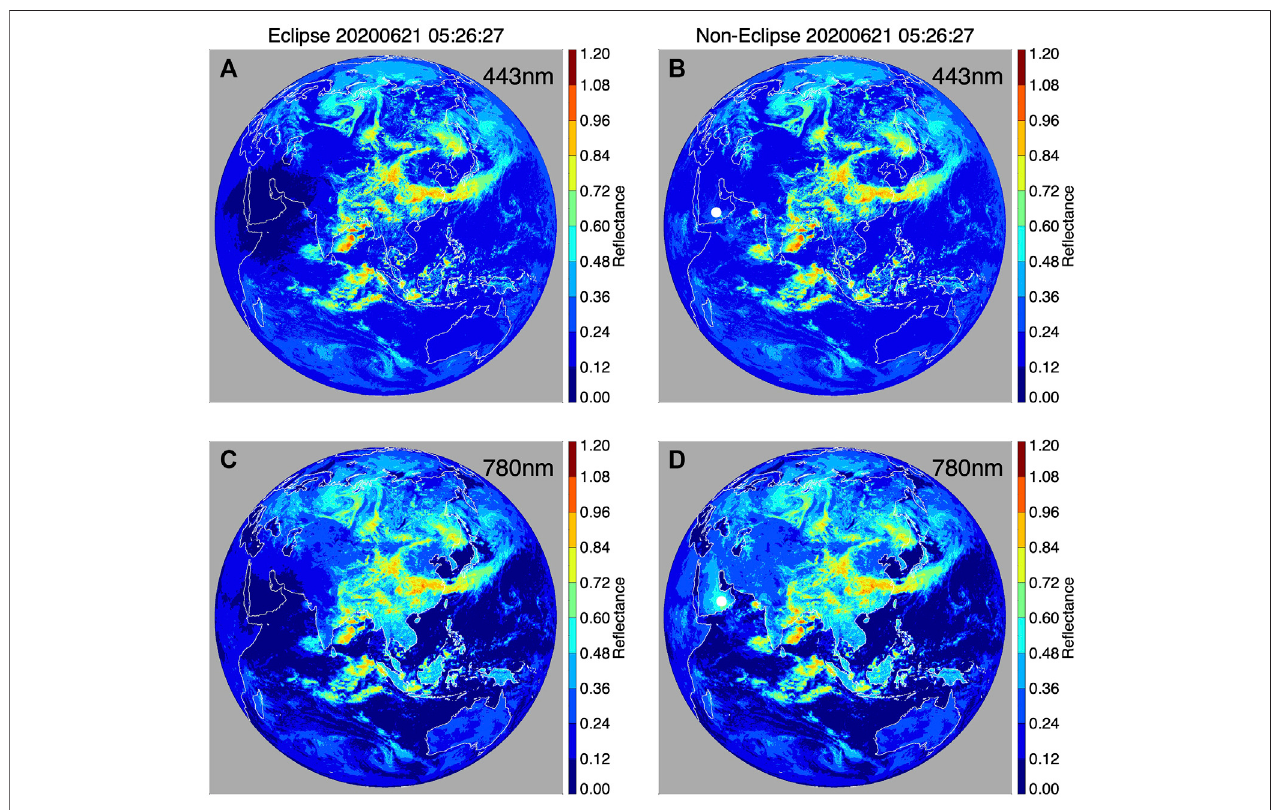
FIGURE 4 | (A) EPIC image at 443 nm acquired during the 21 June 2020 eclipse when the center of the Moon ’ s shadow was in Arabian Peninsula; (B) the recoveredimageforhypotheticalnon-eclipseconditionsforimagein (A) ; (C) similarto (A) butfor780 nm; (D) similarto (B) butfor780 nm.Thewhitecirclesin (B) and (D) are the center of the Moon ’ s shadow with a radius of about 170